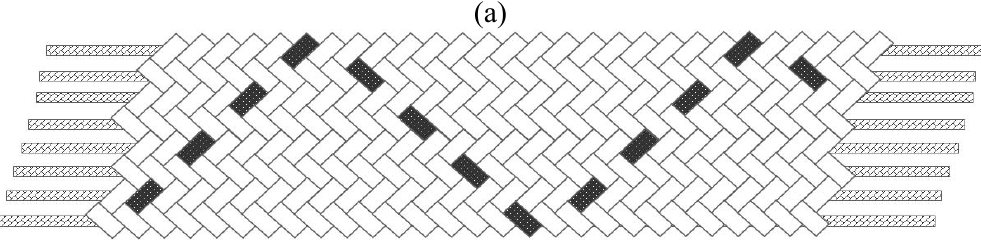
Figure 1. Structure of (a) flat webbing, (b) tubular webbing, (c) the laid-in elastic yarns of the flat and tubular webbings, (d) belt webbing, and (e) elastic yarn traveling back and faced the